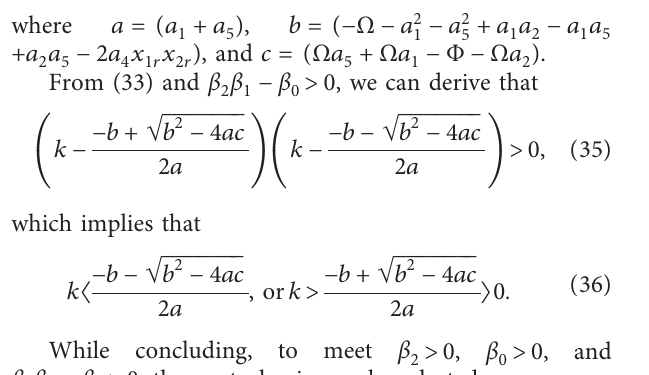
Figure 7: Phase portrait of the state variable x